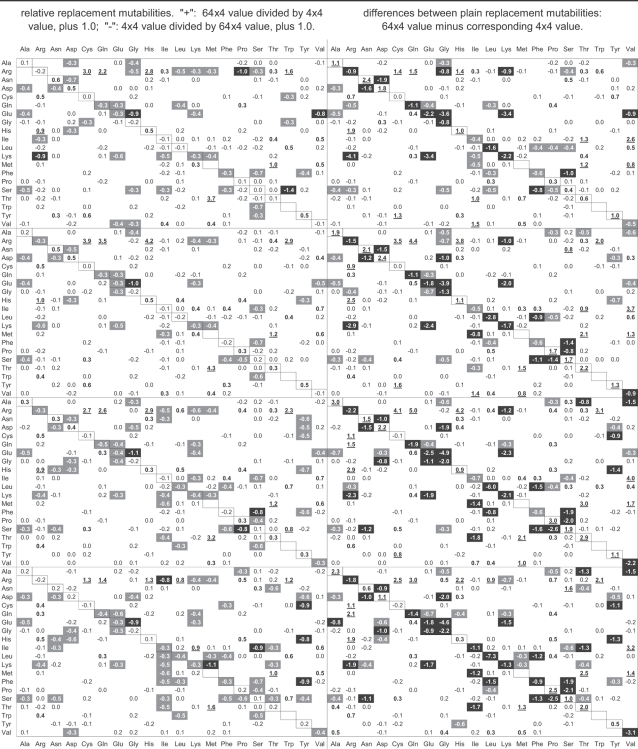
The expected incidence in human coding regions of the amino-acid replacements due to one-base point mutations under intronic 64×4 vs matched 4×4 mutation.Dark cells highlight low 64×4 values and light cells with boldface highlight high 64×4 values (details in Figure 35).